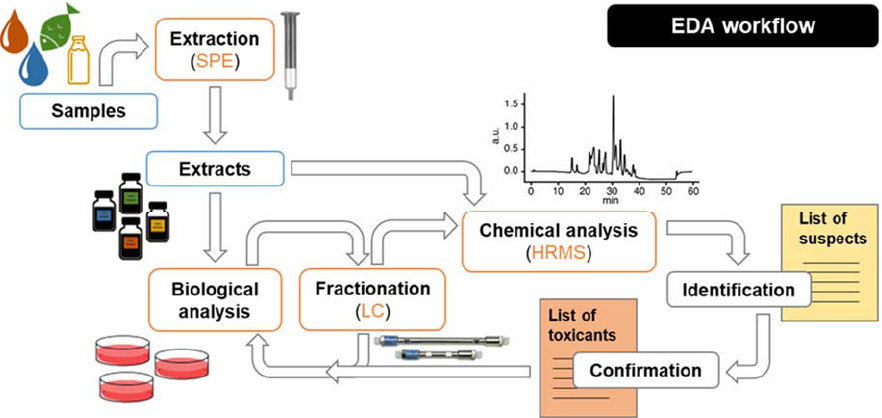
Figure 3. Schematic representation of the workflow entailed by the effect-directed analysis approach. EDA: effect-directed analysis; HRMS: high resolution mass spectrometry; LC—liquid chromatography; SPE: solid ‐ phase extraction.